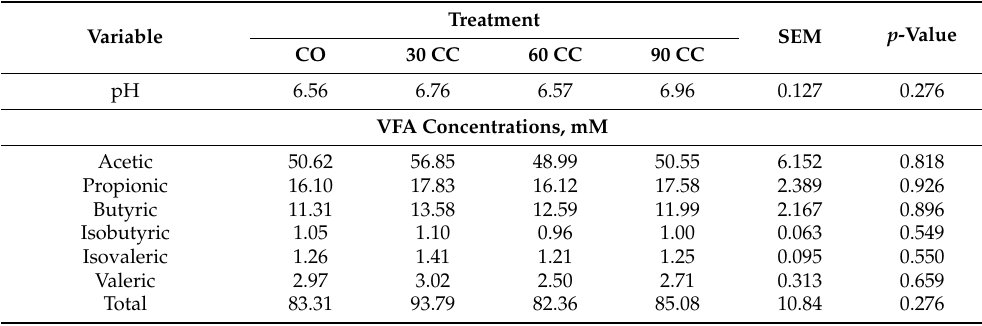
Table 5. Concentrations of VFAs in and pHs of rumen liquor from heifers supplemented with different levels of Cymbopogon citratus